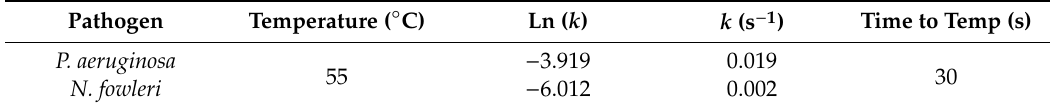
Table 7. Rate of heat inactivation ( k ) for P. aeruginosa and N.